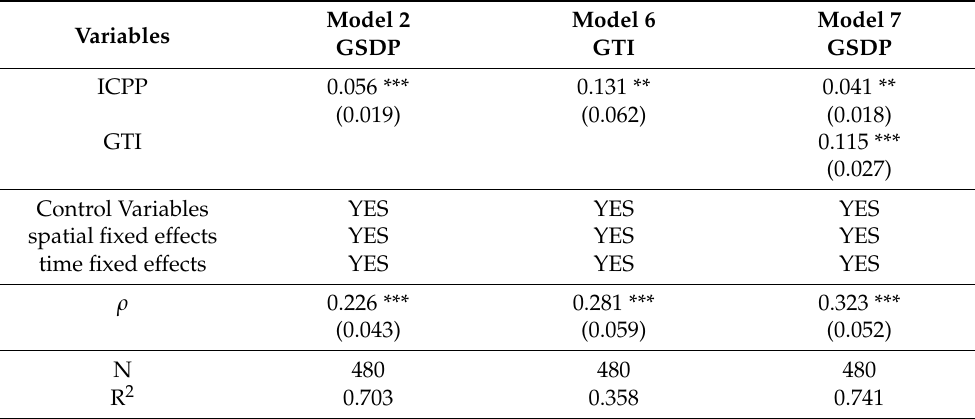
Table 6. The results of the mediating effect